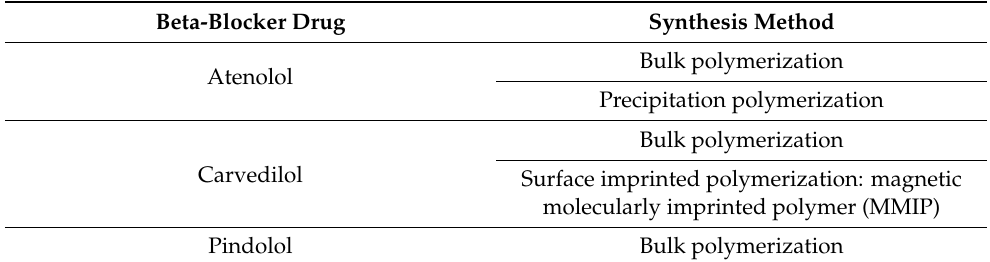
Table 3. Synthesis methods of molecularly imprinted polymers that have been developed for beta- blocker